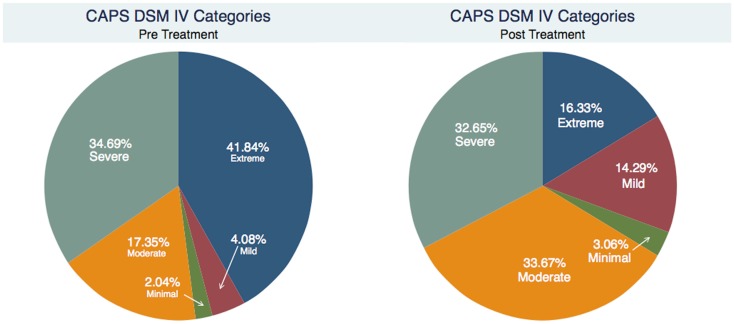
Percentage of CAPS total severity scores pre and 1 week post-treatment for each category (Minimal, Mild, Moderate, Severe, and Extreme).